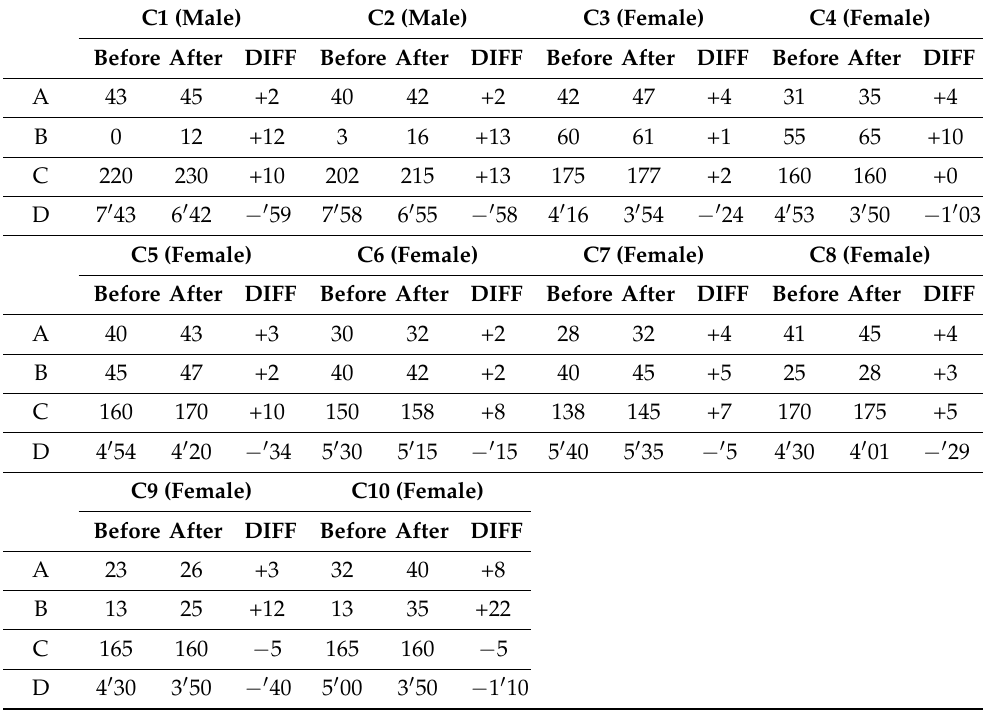
Table 3. Statistical difference analysis of physical fitness of the control group before and after the experiment.